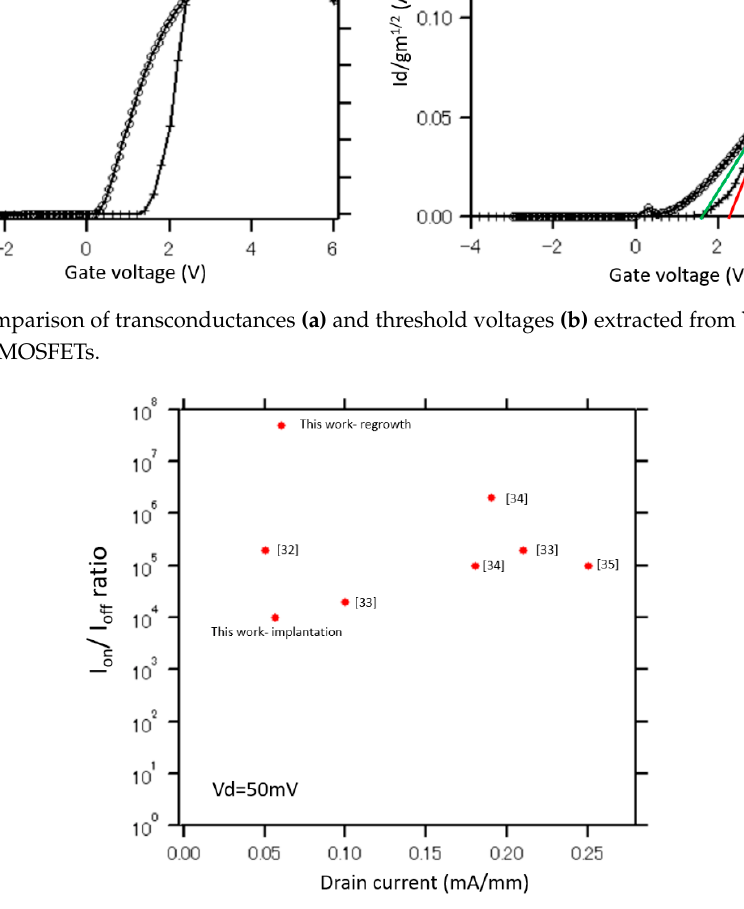
Figure 7. Comparison of I on /I off ratios obtained in this work and previous reports.